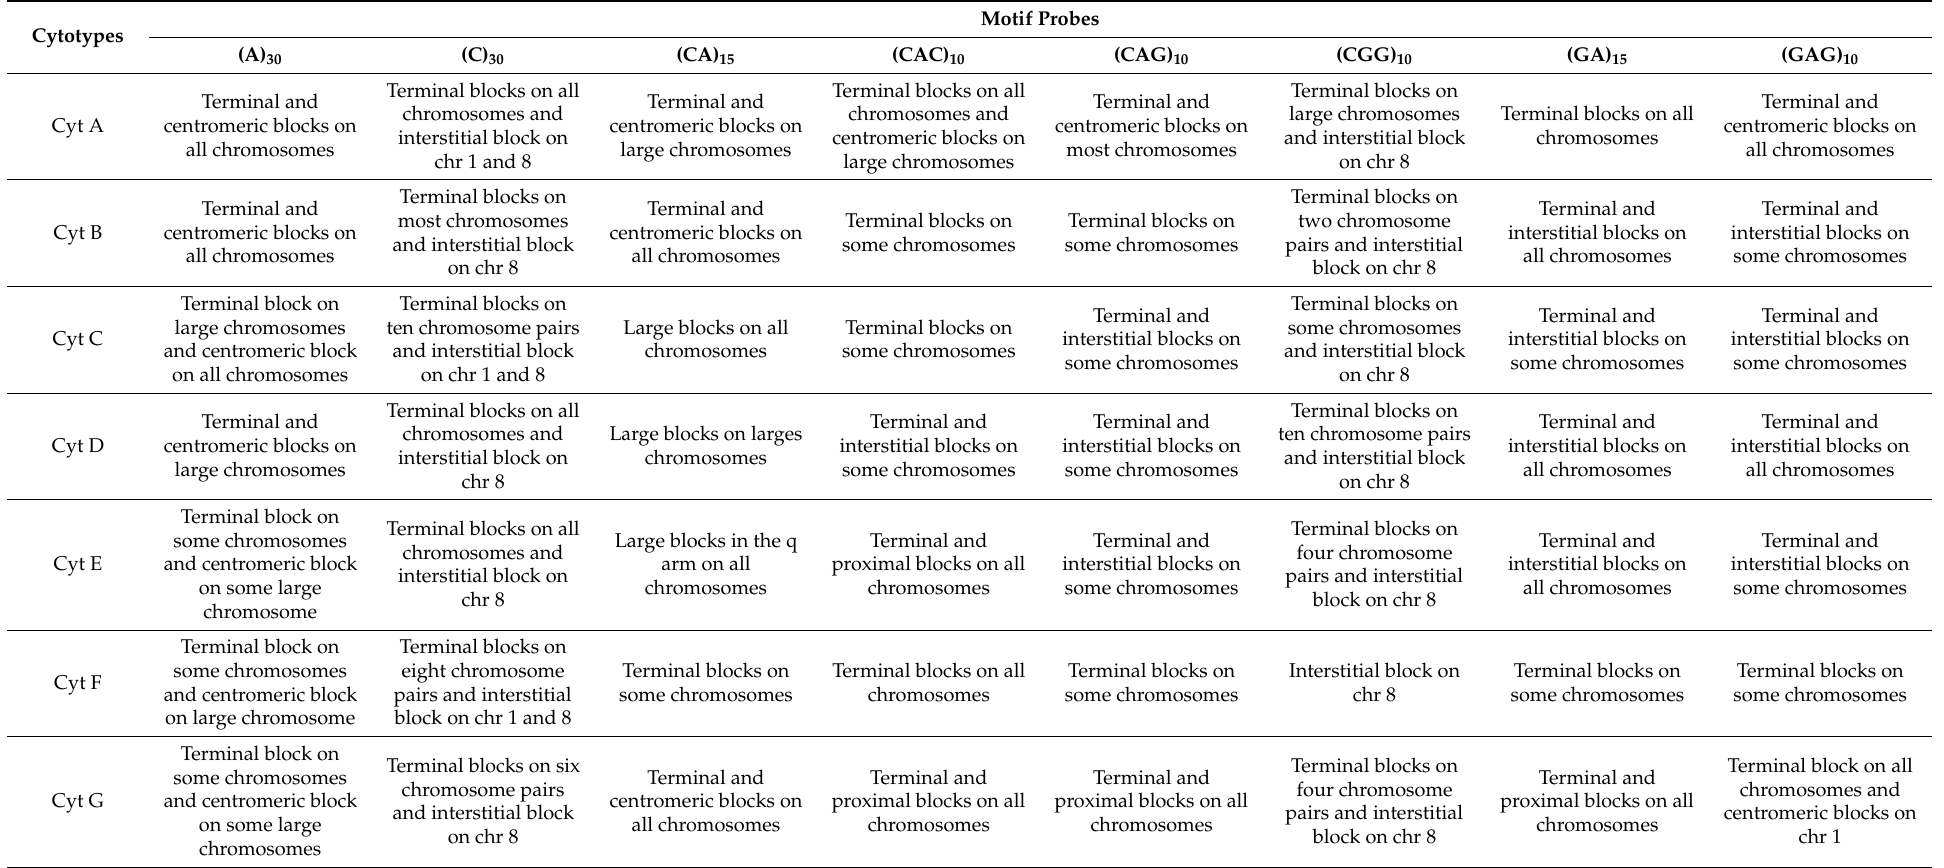
Table 3. Hybridization of eight microsatellites in seven cytotypes (A–G) of Ctenomys minutus